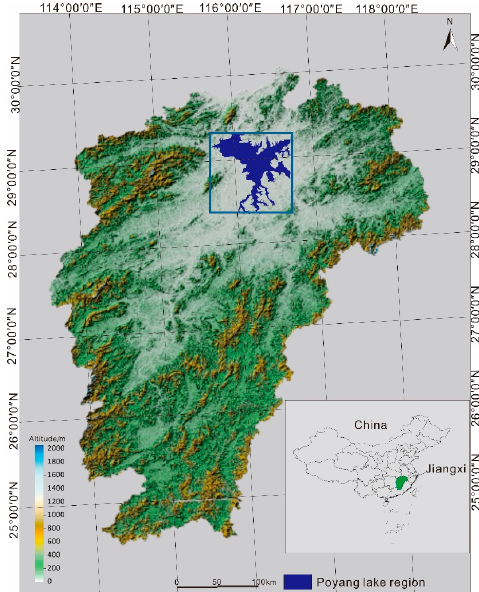
Figure 1. Map of the Poyang Lake, Jiangxi Province, China.